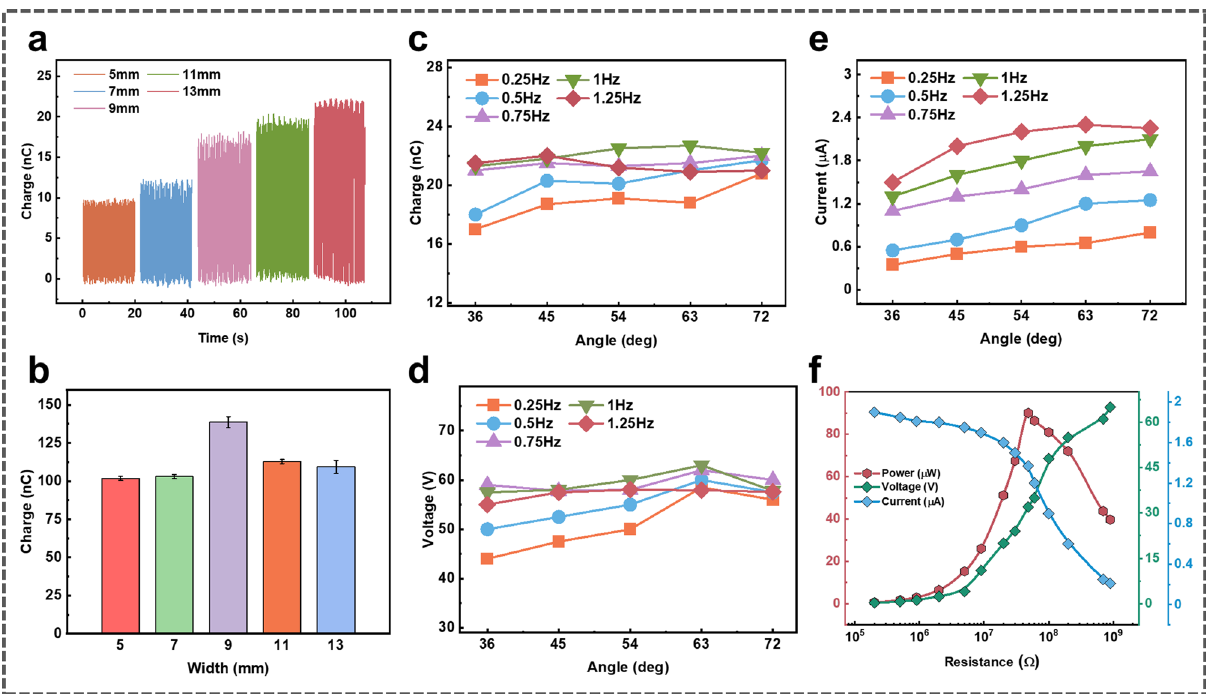
Fig. 3 The electrical output performance of the internal TENG. a Transferred charge quantity under various electrode widths at f = 0.25 Hz and Deg = 27°. b The calculated transferred charge amount in a period under various electrode widths. c–e Point plots of the c transferred charge, d open-circuit voltage and e short-circuit current under diverse frequencies and swing amplitudes. f The output current, output voltage, and power dependence of the external load resistance at f = 1 Hz and Deg =